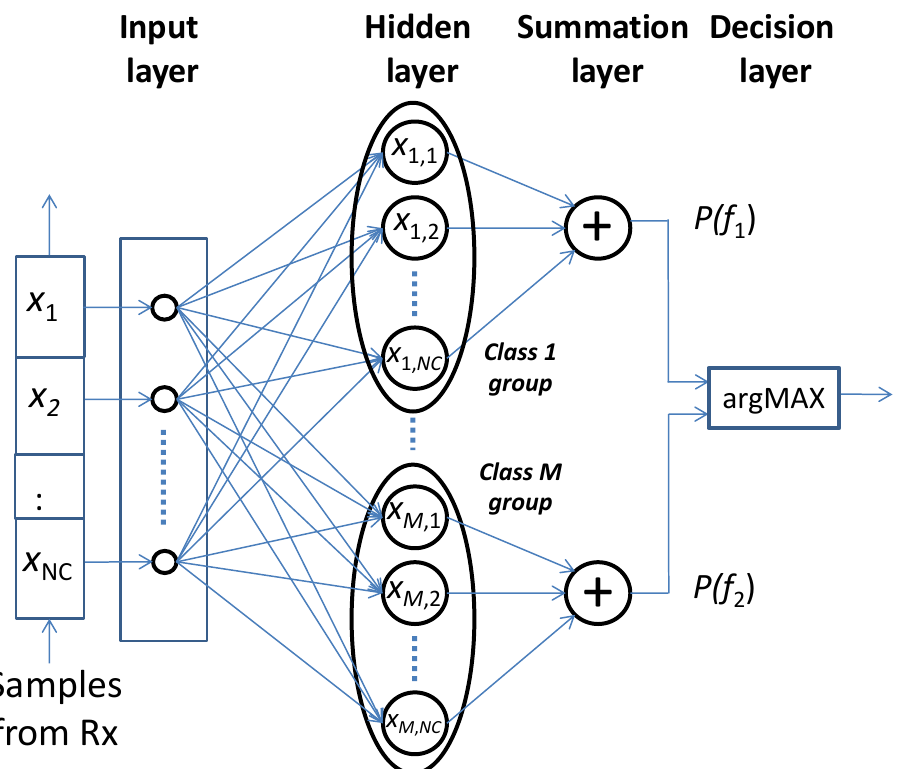
Figure 2. PNN with input, hidden, summation and output layers. PNNs have just one training parameter for smoothing the PDFs. The spread of the Gaussian function ranges from zero (local nodes connected) to one (all input nodes connected) and hence impacts both the accuracy and the complexity. The spread parameter σ is the standard deviation of the underlying Gaussian distribution or Parzen